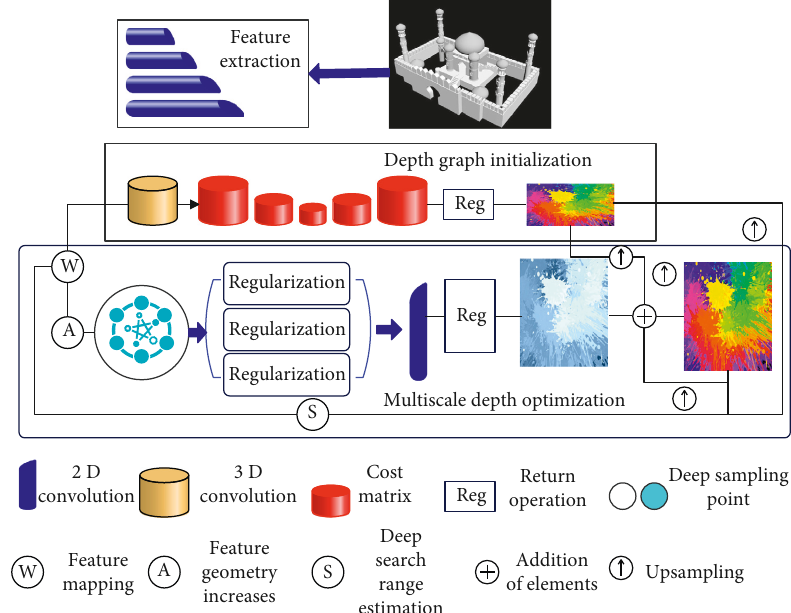
Figure 7: Network structure diagram of multiview image depth estimation.